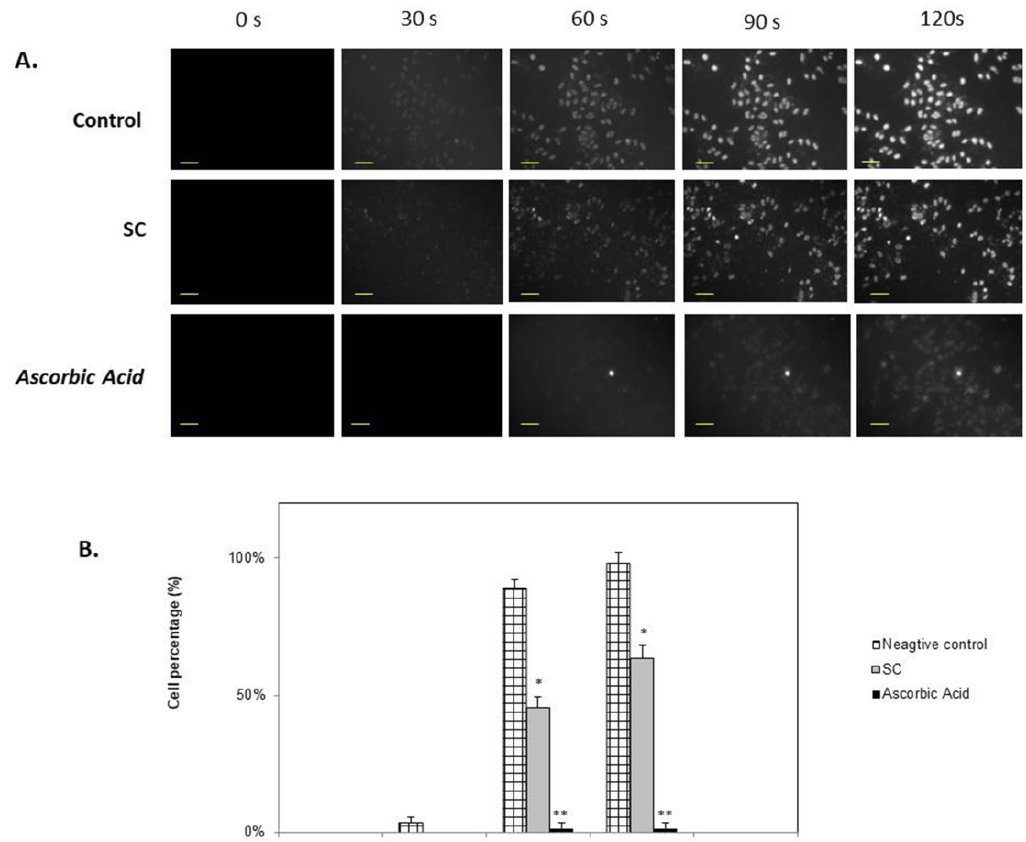
Figure 4. Cytoprotective analysis of macroalgae extracts (0.01%) against UV-A irradiation in HeLa cells for 2.5 min irradiation. ( A ) Nucleic staining with DAPI was conducted to determine cellular damage. Scale bar: 200 μm ( B ) Dead cell percentage of HeLa cells irradiated with UVA. * is considered significantly different to control ( p < 0.05); ** is considered highly significantly different compared to control ( p < 0.01).